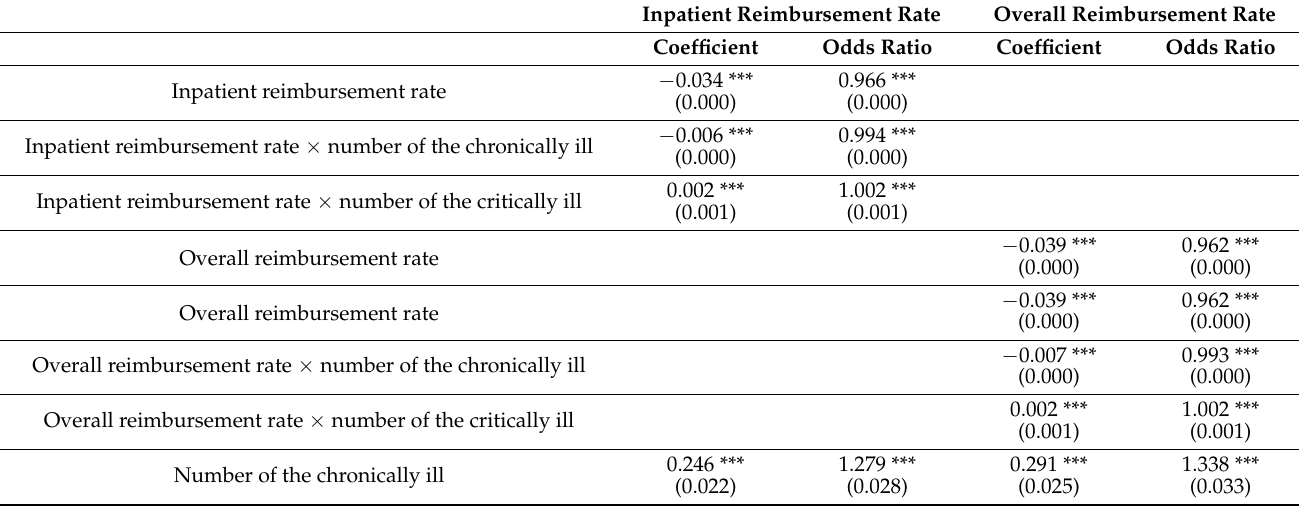
Table 4. Robustness